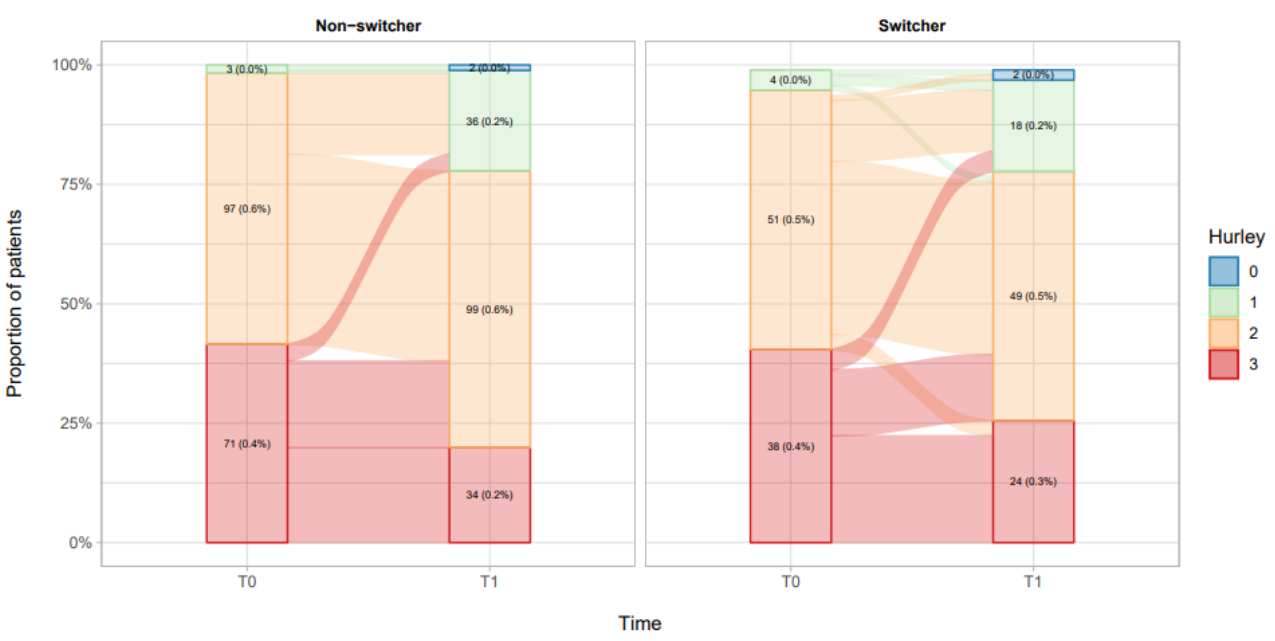
Figure 3. Visual description of Hurley scores among switchers and non-switchers.